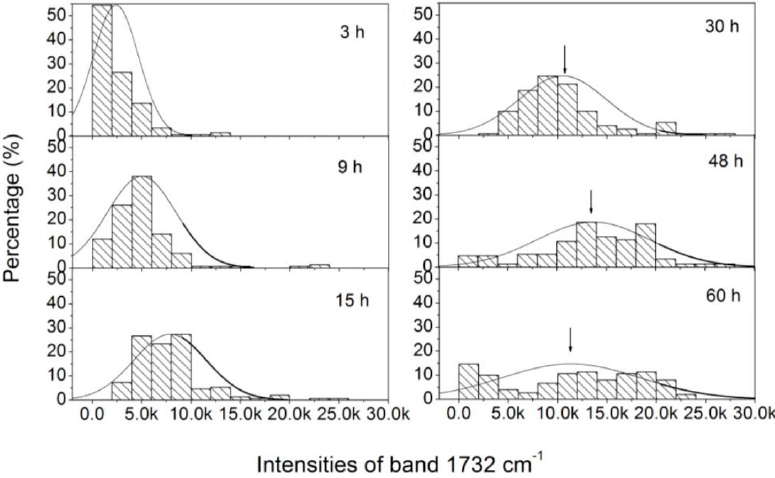
Figure 5. Histograms of intensities of Raman band at 1732 cm − 1 , obtained from 150 C. necator H16 cells after 3, 9, 15, 30, 48, and 60 h of incubation.